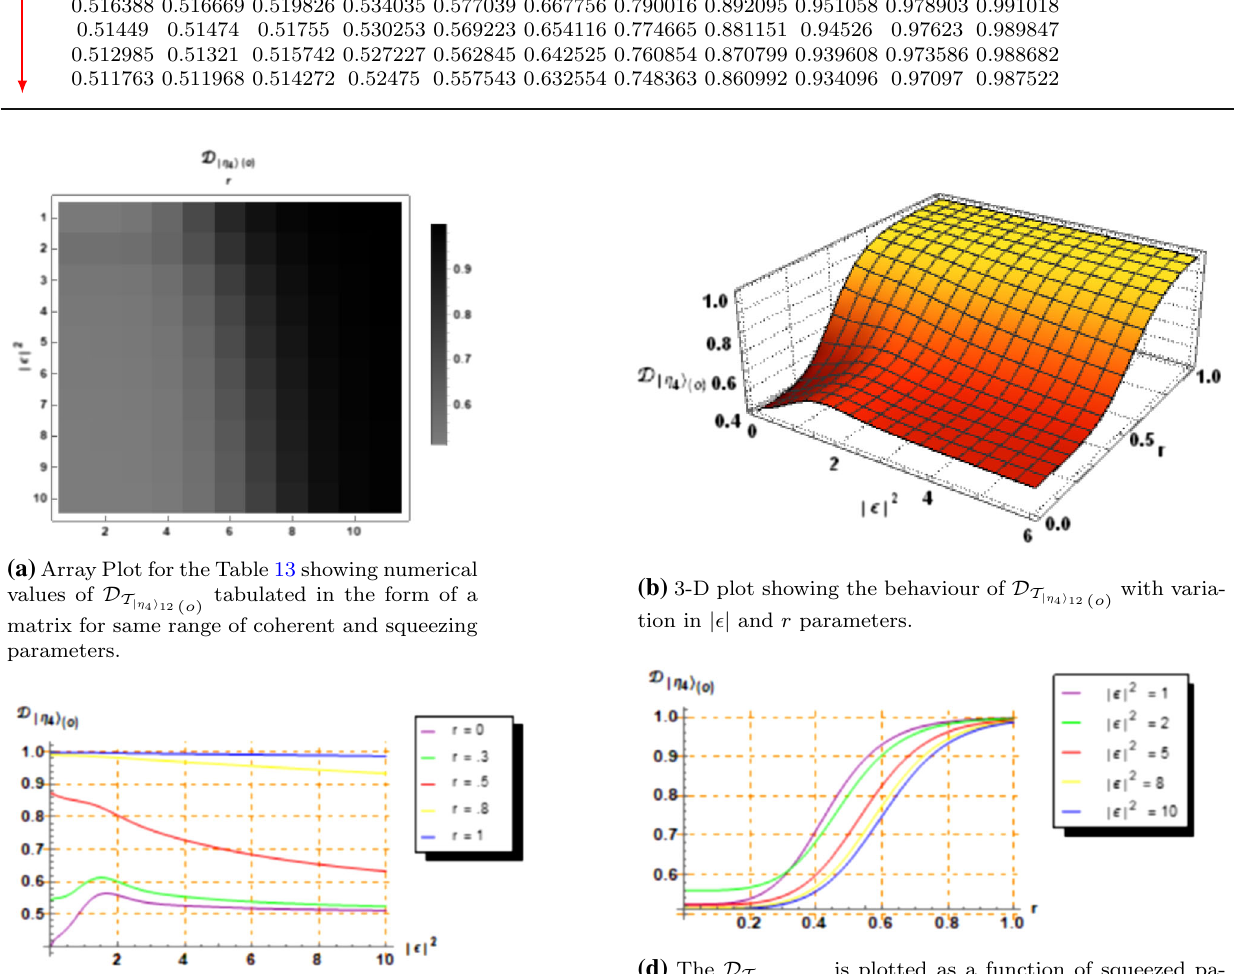
Fig. 20 a is the array plot and b – d are the respectively 3-D and 2-D plots for the D T in 4th quasi-Bell state of TMSEC states, plotted as a function of coherent parameter | (cid:11) | and squeezing parameter r .